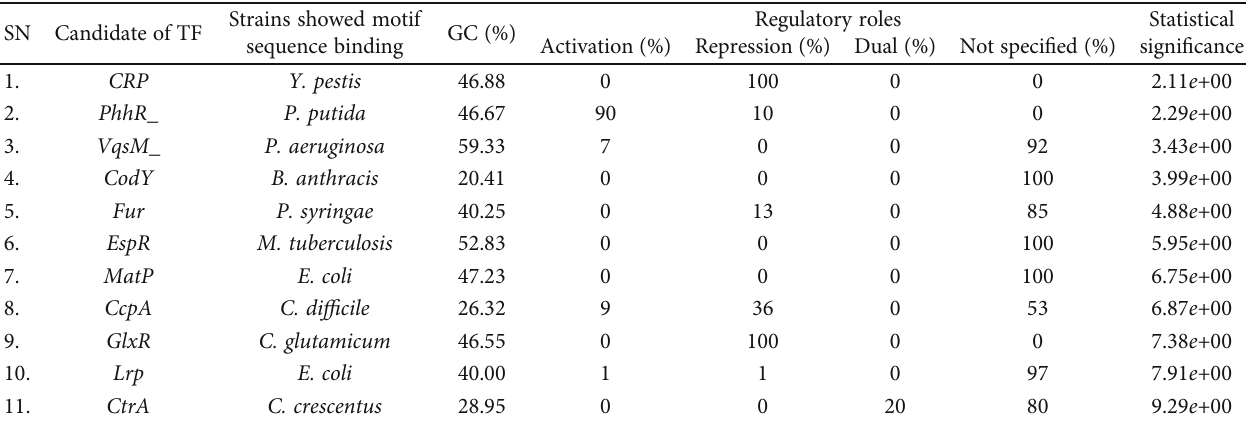
Table 4: List of matching candidates for EXPREG transcription factor (TF). Strains showed motif SN Candidate of TF